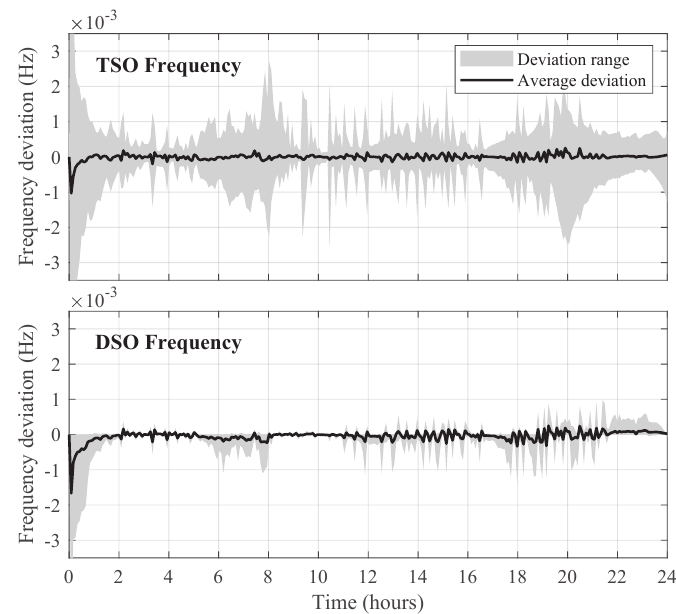
Figure 5. Case 3—Frequency deviations in the TSO and DSO networks.